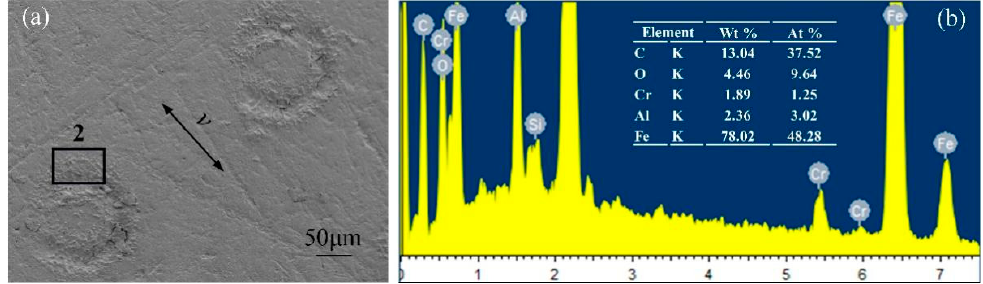
Figure 13. SEM images and EDS analysis of GCr15 metal surface under optimal coupling texture parameters: ( a ) SEM image of the sample surface with optimal coupling texture parameters; ( b ) corresponding EDS analysis.